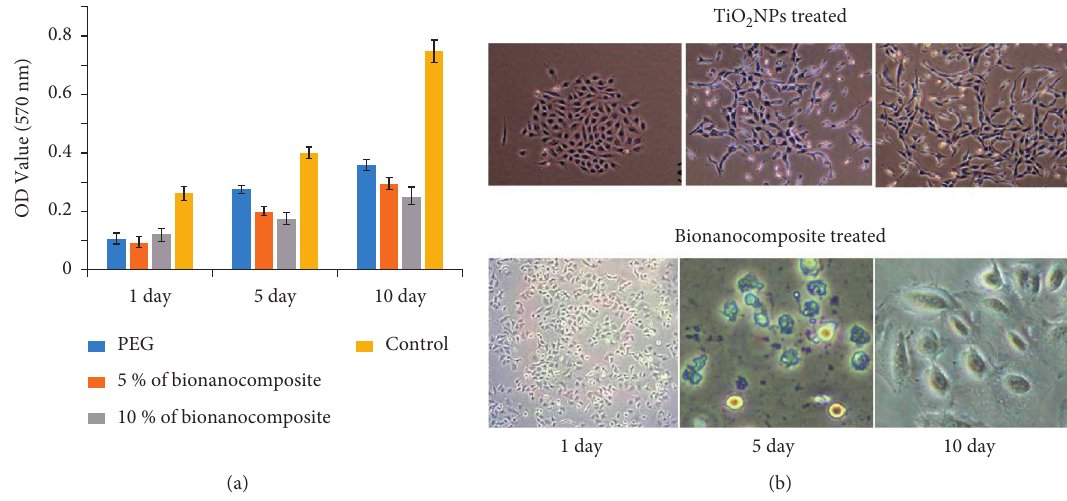
Figure 13: (a) MTT viability assay of A549 cells after 1-, 5-, and 10-day cell culture on PEG and bionanocomposite in comparison to the control (PBS) and (b) SEM images of the fibroblast (A549 cells) on TiO 2 NPs and bionanocomposite at 1, 5, and 10